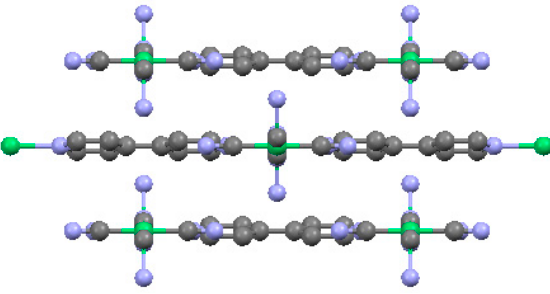
Figure 18. 2-D sheets in Ni-Bpy are connected to each other via van der Waal’s forces and hydrogen bonding (view along b -axis; C-grey, N-blue,